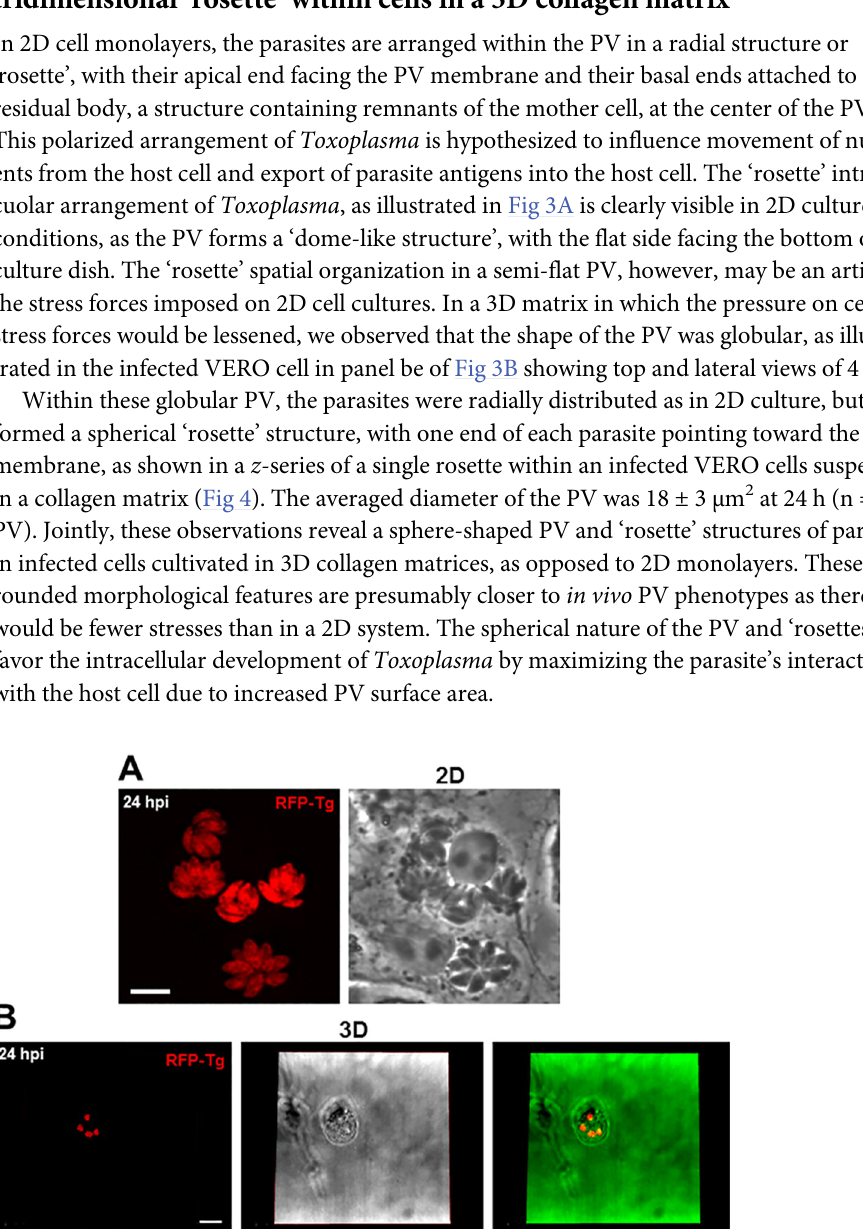
PLOS ONE | https://doi.org/10.1371/journal.pone.0208558 December6,